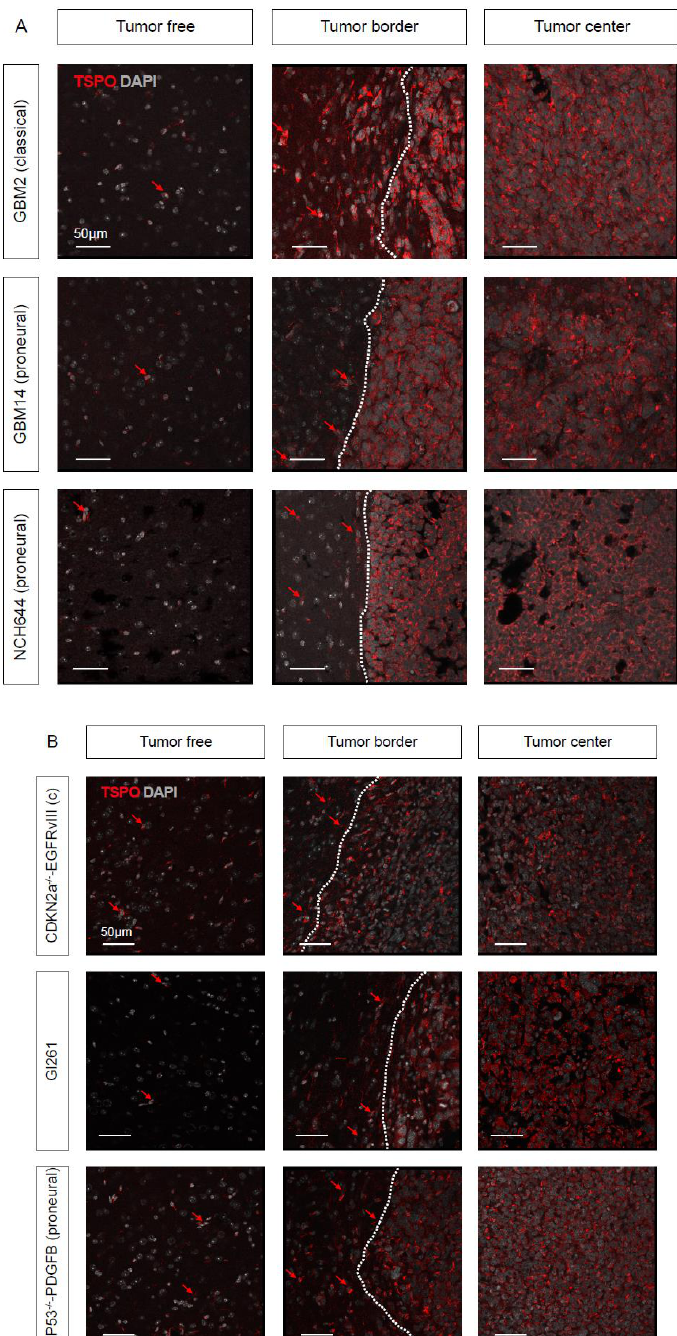
Figure 2. TSPO is expressed in mouse models of different GBM subtypes; ( A ) Human GBM stem-like cells (GSCs) were orthotopically xenografted in immunodeficient mice. Immunofluorescent staining against TSPO (red) and nuclear counterstaining for DAPI (gray) shows a high level of expression in classical (GBM2) and proneural (GBM14 and NCH644) human GBM subtypes. ( B ) TSPO immunofluorescent staining (red) and nuclear counterstaining (gray) of murine Gl261 and the classical ( cdkn2a KO EGFRvIII ) and proneural ( p53 KO PDGFB ) murine GBMs. ( A , B ) Scale size is indicated in individual micrographs. A representative image from a cohort of five mice per experimental group is shown.